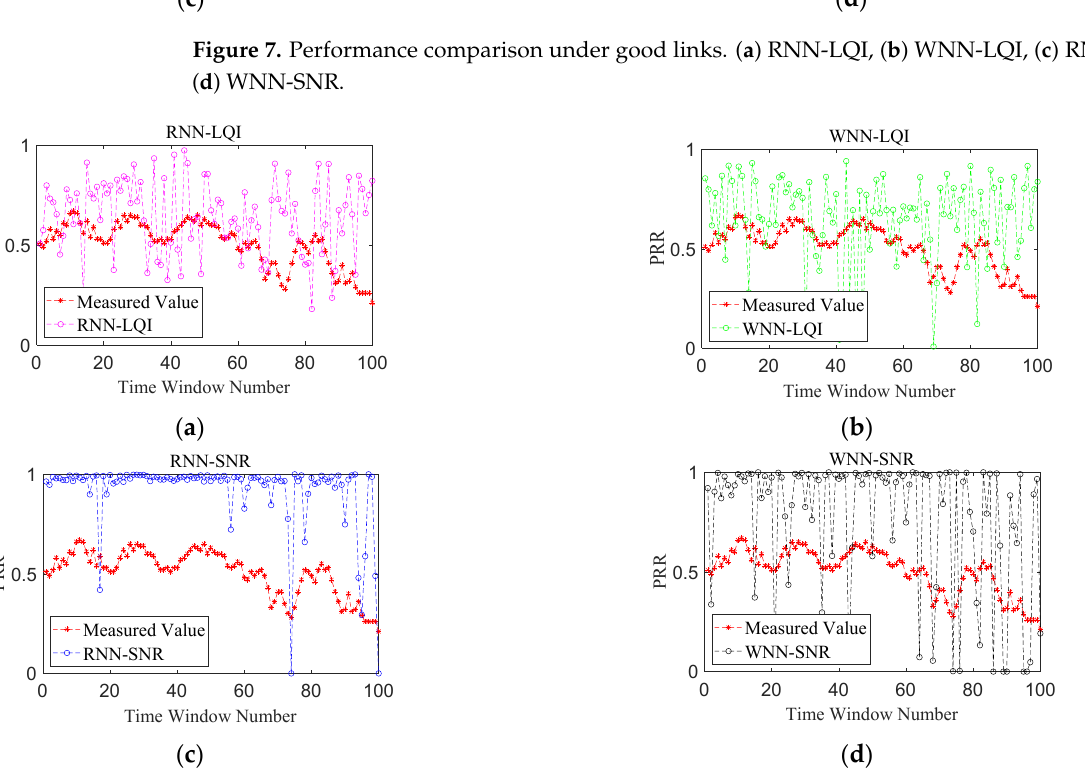
Figure 8. Performance comparison under moderate links. ( a ) RNN-LQI, ( b ) WNN-LQI, ( c ) RNN-SNR, ( d ) WNN-SNR.